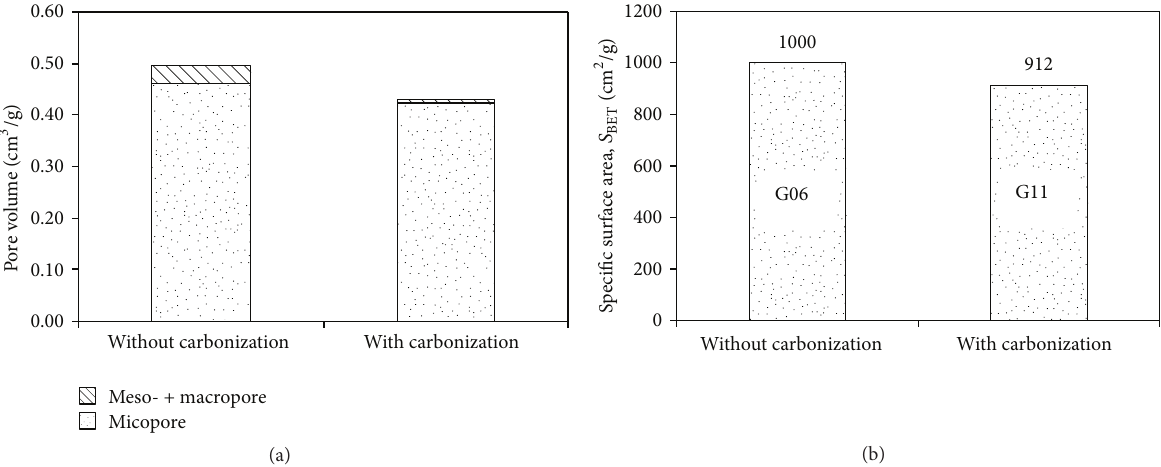
Figure 11: Effect of carbonization step on (a) pore volume and (b) specific surface area ( 𝑆 BET ) of activated carbon from coconut shell by gasification with potassium hydroxide and carbon dioxide at 600 ∘ C for 180 min and chemical ratio of